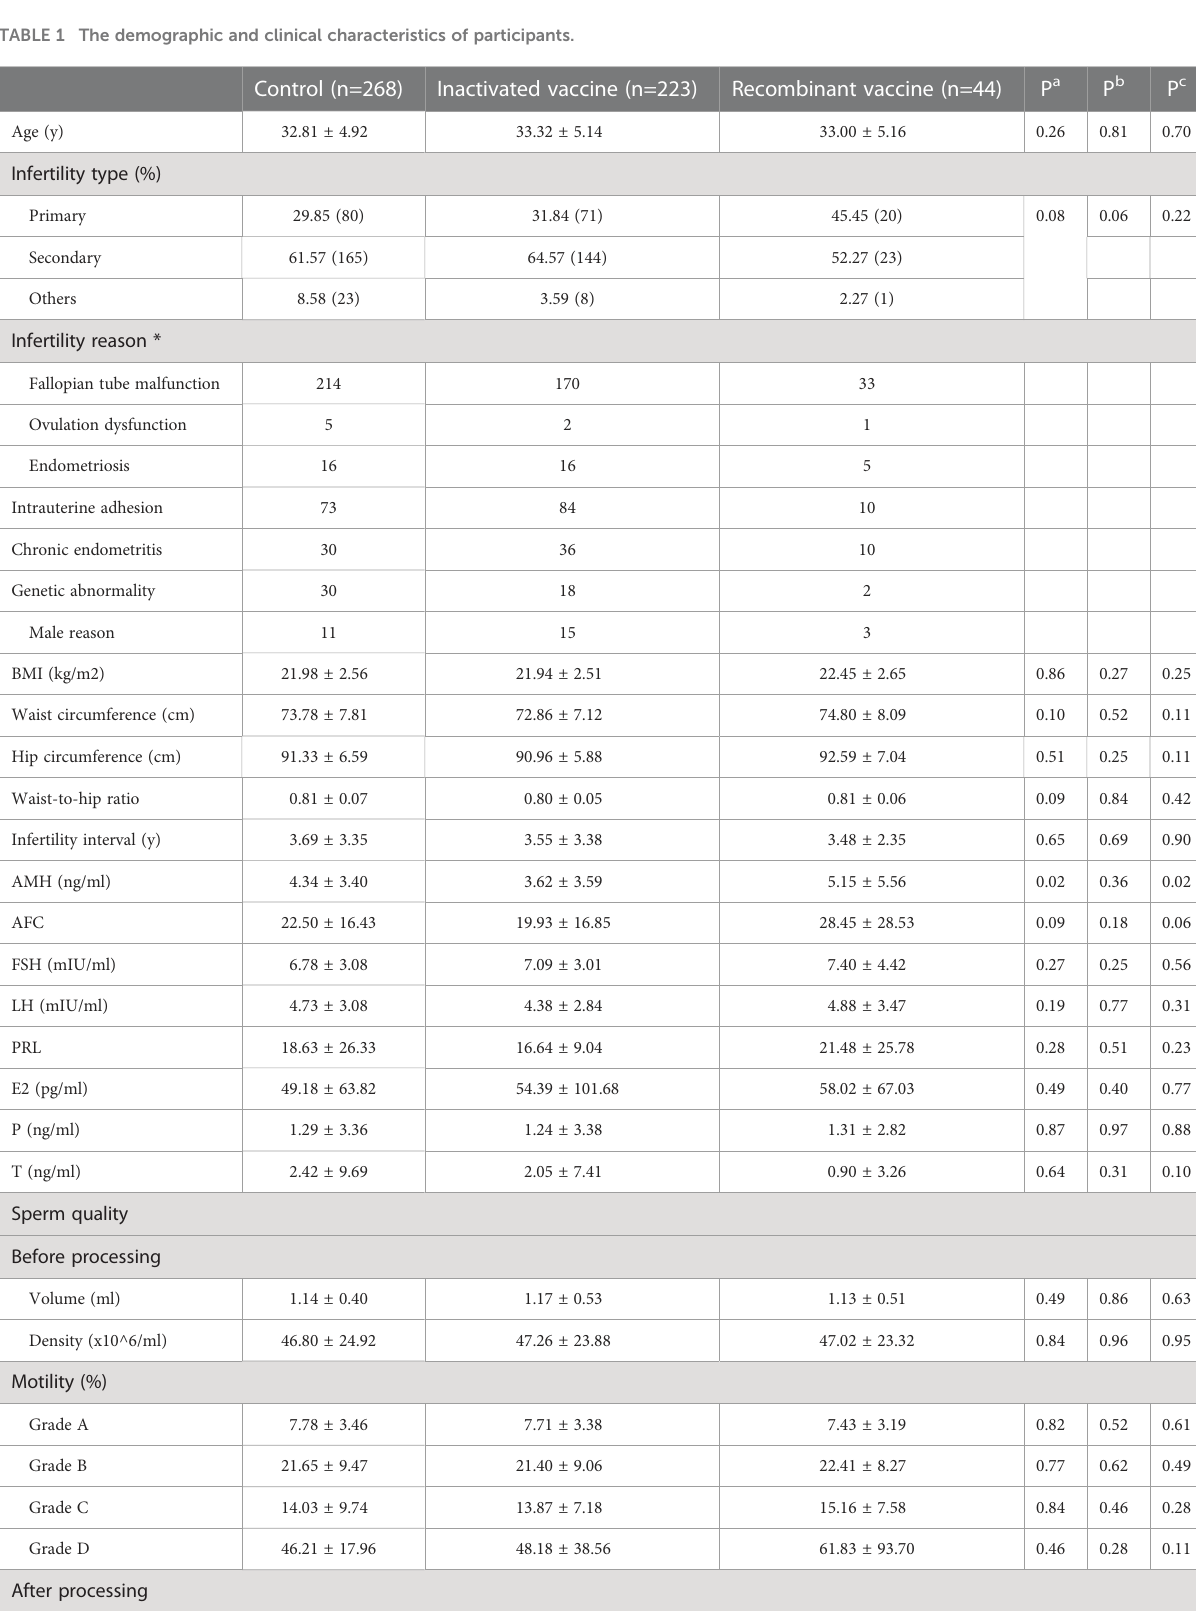
TABLE 1 The demographic and clinical characteristics of